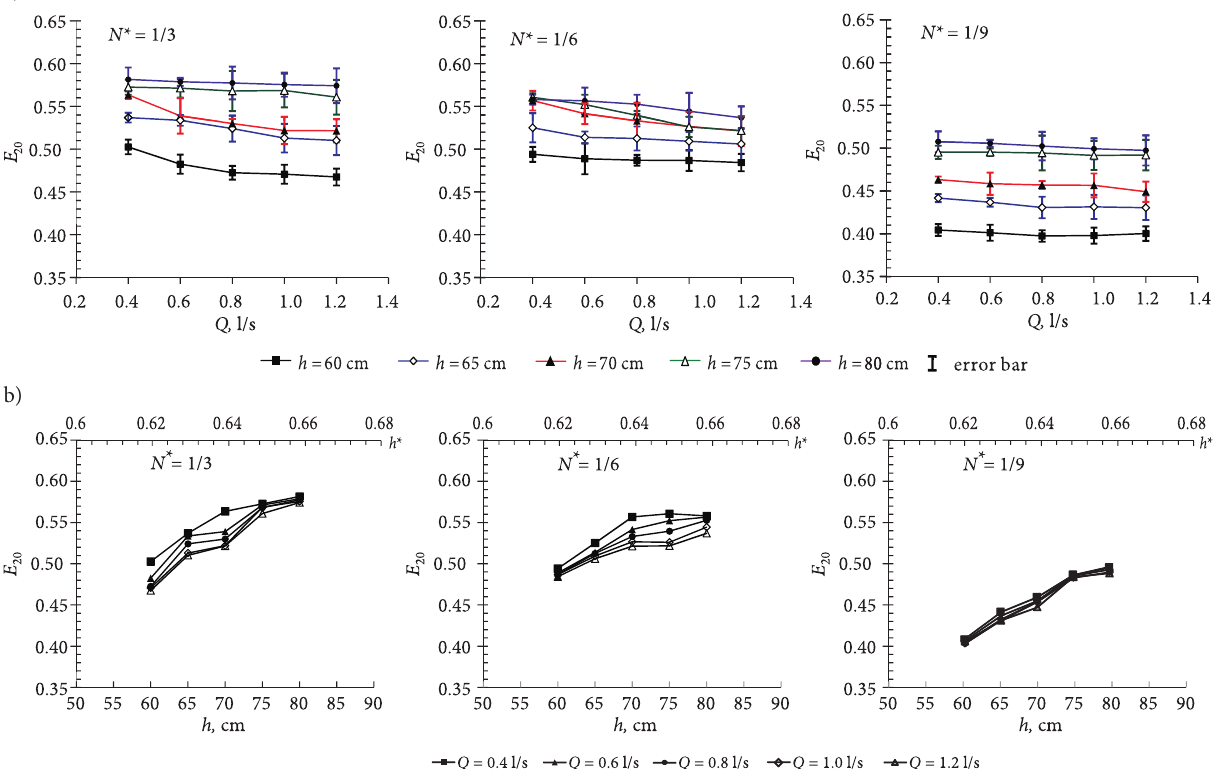
Fig. 6. Variation of oxygen-transfer efficiency E